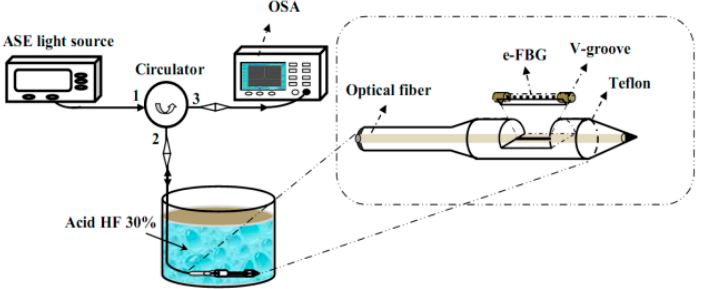
Figure 12. Setup of the fiber laser sensor system based on etched-Bragg grating sensing probe for determination of the low nitrate concentration in water.